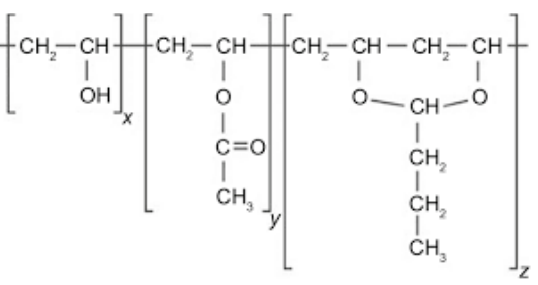
Figure 1. Chemical structure of the terpolymer poly(vinyl butyral) containing butyral (z ≈ 0.8) and hydroxyl (x ≈ 0.2) side groups with a small amount of acetate (y ≈ 0.01) units.